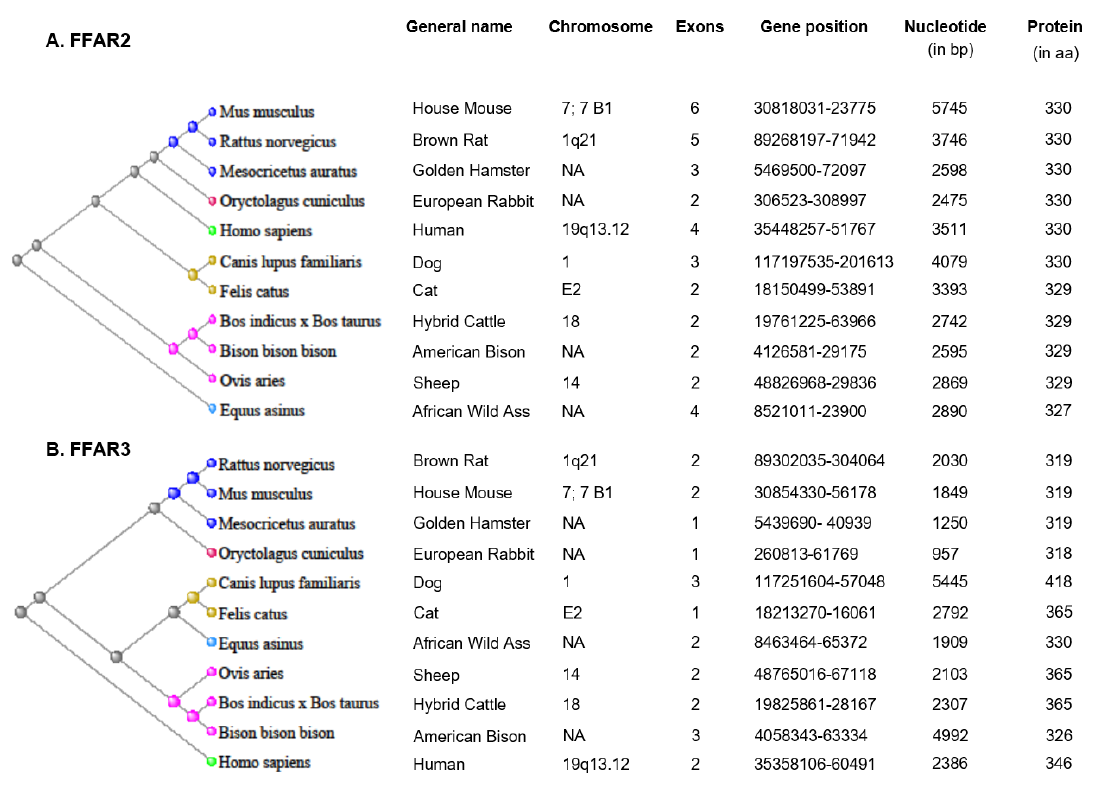
Figure 1. Phylogenetic tree depicting genetic closeness and differences in Free fatty acid receptor 2 (FFAR2) ( A ) and Free fatty acid receptor 3 (FFAR3) ( B ) among different animal species.